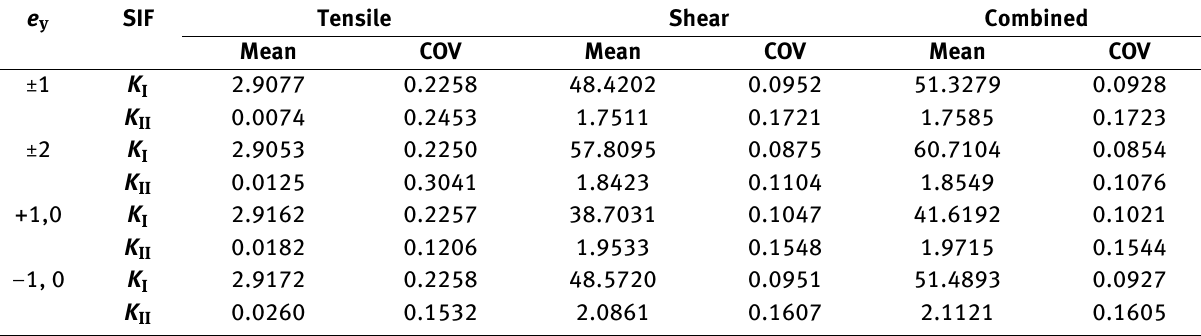
Table 4: Effect of eccentricity on the normalized mean and COV of K I and K II of edge cracked FGMs plate subjected to uniaxial tensile, shear and combined